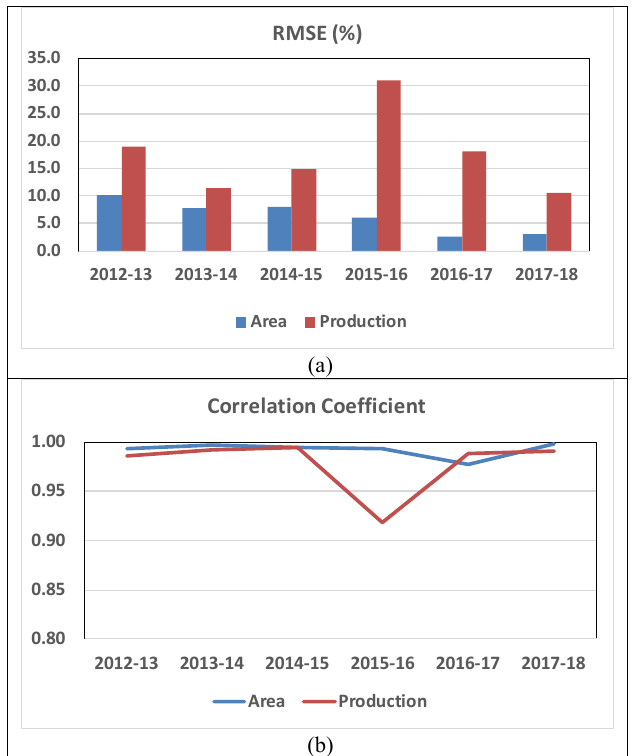
Figure 7. Comparison of state level estimates of potato crop with government estimates, as seen through (a) RMSE (%) and (b) correlation coefficient, in different years.